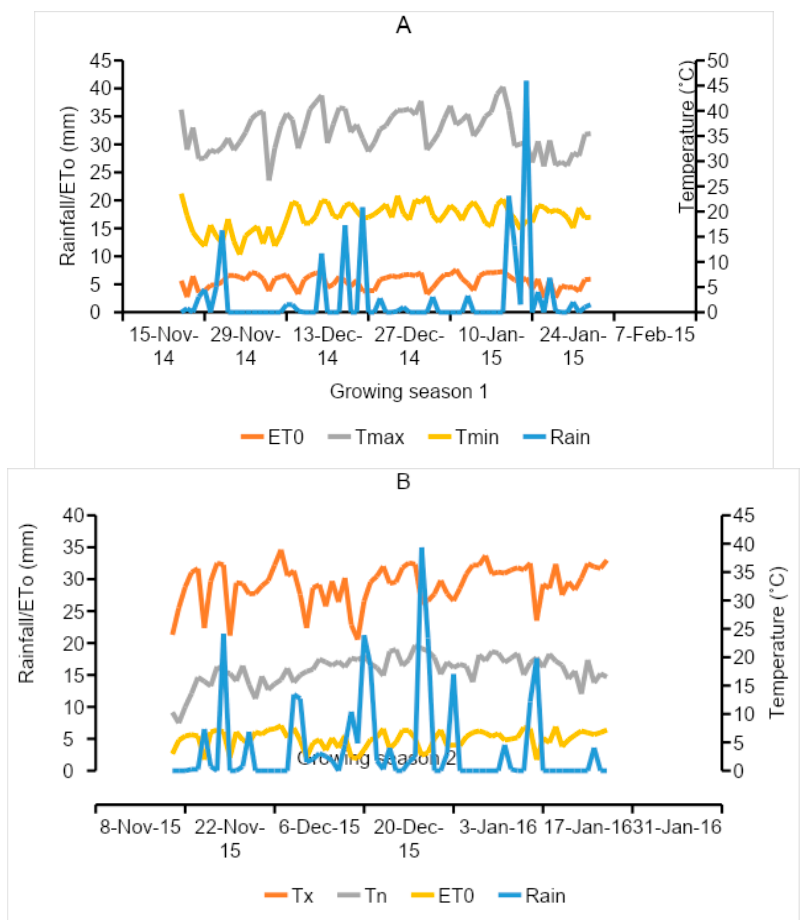
Figure 1. Weather data (monthly meteorological) for the 2014/15 season ( A ) and 2015/16 season ( B ) at Roodeplaat, Pretoria, South Africa. The reported values are daily climatic data during season 1 (S1) and season 2 (S2) from day of direct seeding of cowpea and transplanting of amaranth until the end of harvest. Legend: T max : maximum temperature. (°C); T min : minimum temperature. (°C); Rain: Rainfall. (mm); ET 0 : Reference evapotranspiration. (mm).